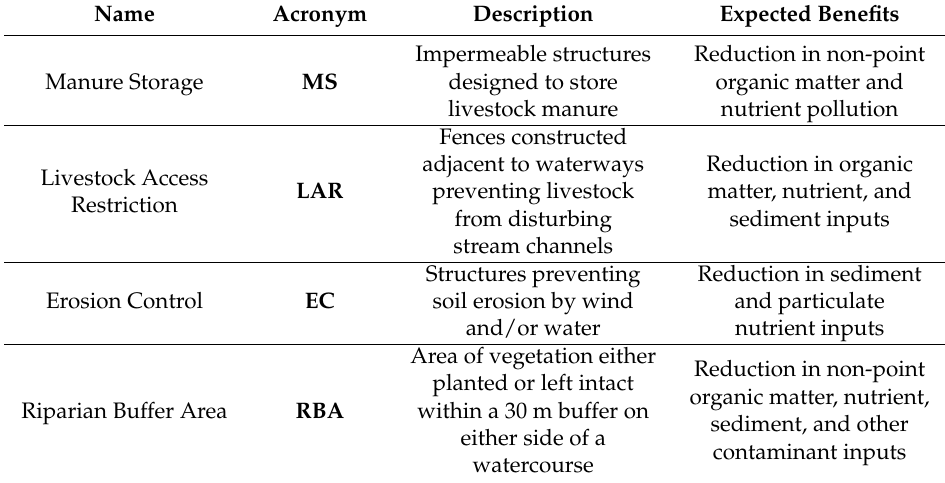
Table 1. Descriptions and expected benefits of four structural best management practices included in this